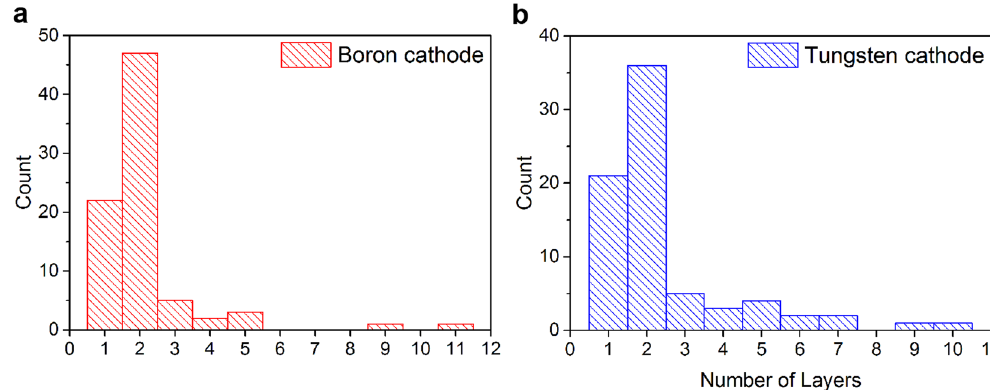
Figure 1. BNNTs synthesized with ( a ) boron and ( b ) tungsten cathodes show similar results. The tubes were primarily single and double